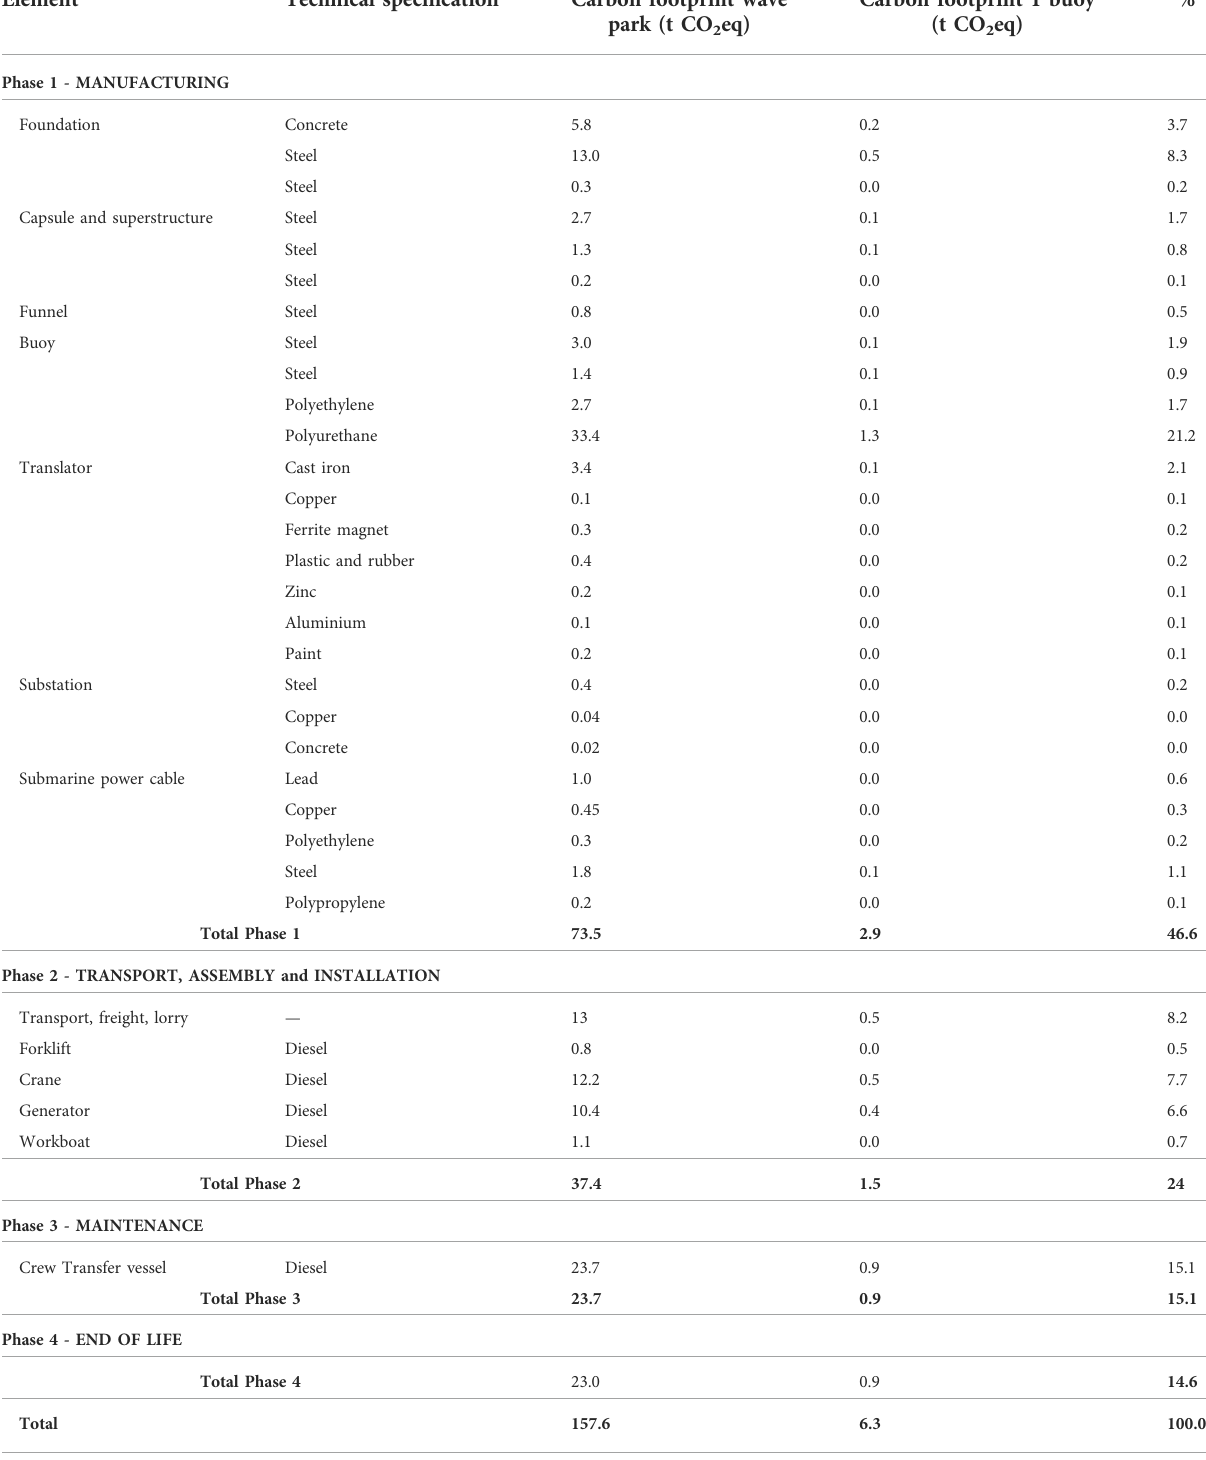
TABLE 7 Total GWP (t CO 2 eq) impact category results for the seabed-based buoy and values for individual